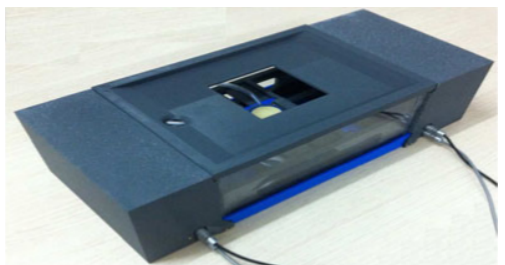
Figure 11. Medsonic system developed for small animal studies [64]. Acoustic coupling relies on the submersion of the treatment region of the animal inside the water